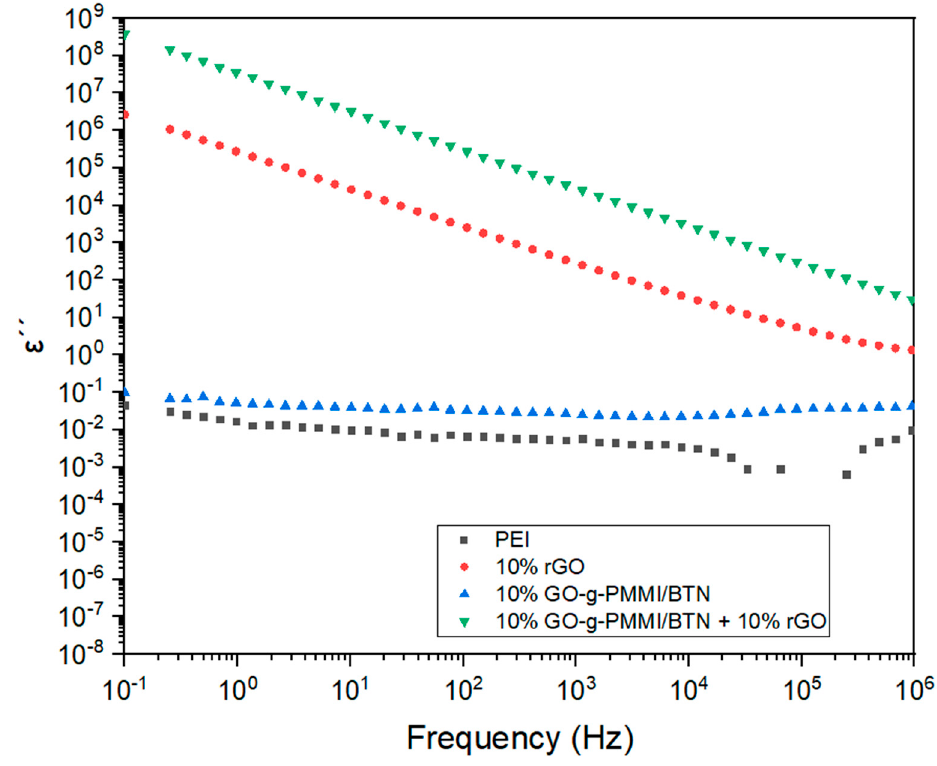
Figure 11. Loss factors of PEI and nanocomposites filled with rGO, GO-g-PMMI/BTN, and GO-g- PMMI/BTN+10 wt.% rGO as a function of frequency.